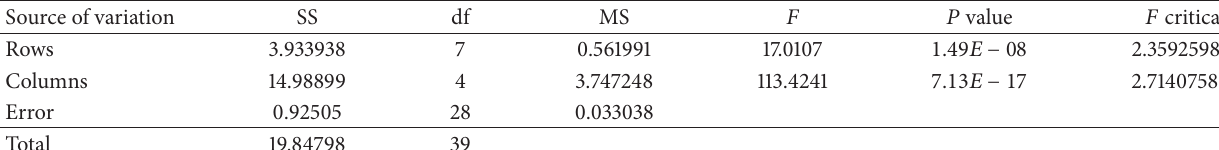
Table 10: VMA test results (ANOVA: two-factor without replication).